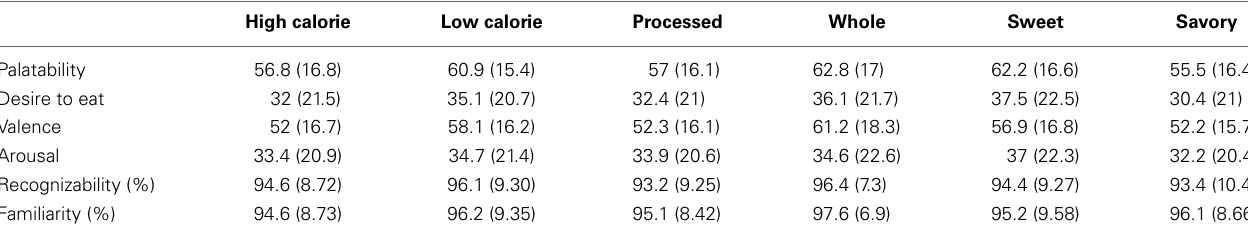
Table 2 | Subjective ratings as a function if different food types (mean, standard